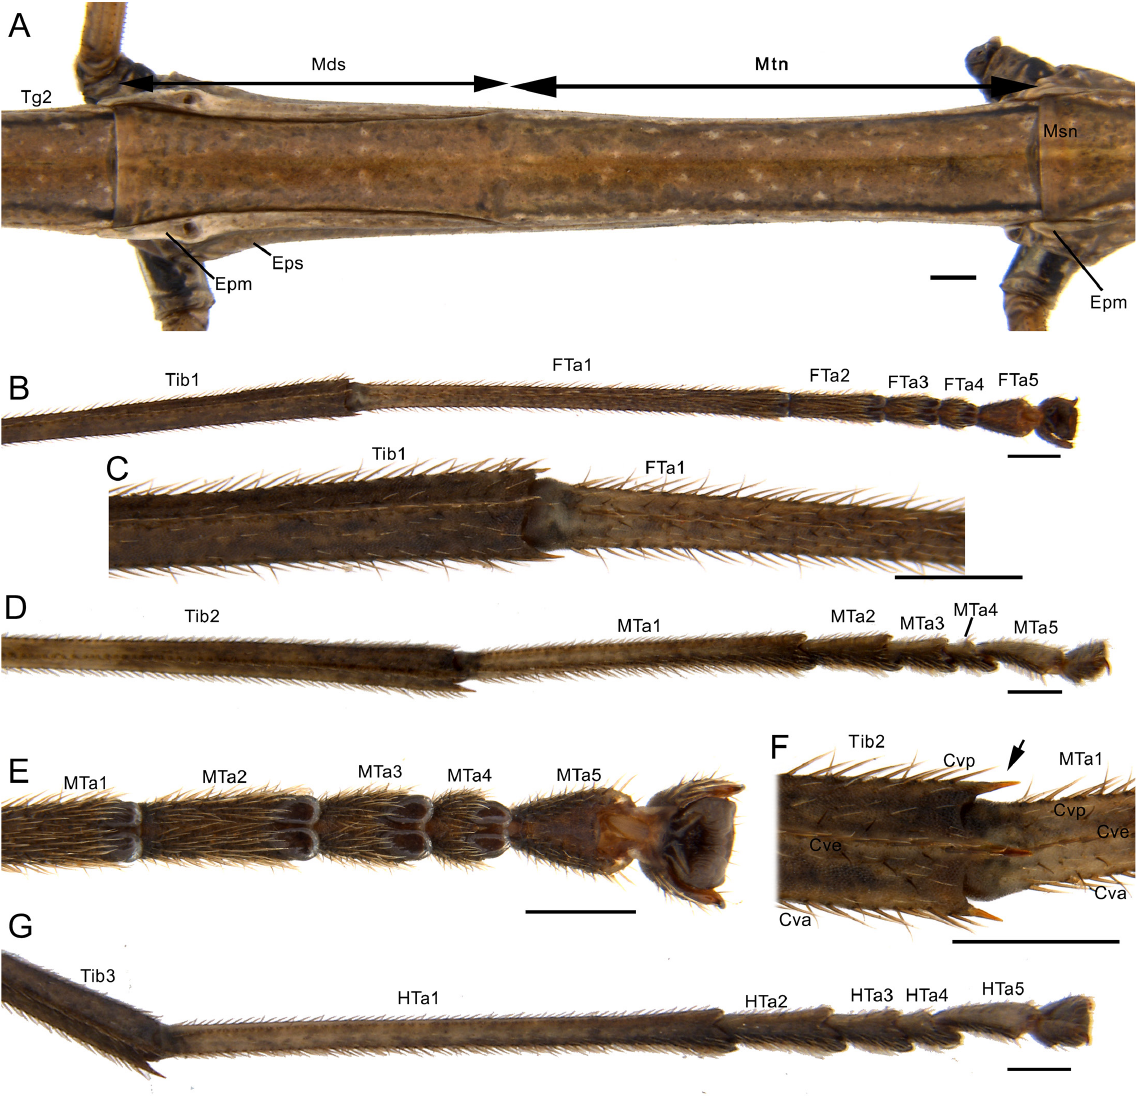
Fig. 39. Arumatia motenata Ghirotto gen. et sp. nov., paratype, ♂ (MZUSP V0602), thorax and leg morphology. A . Metathorax and median segment in dorsal view, arrows indicate the length of each segment. B . Left fore tarsus, ventral view. C . Detail of left fore tibia and tarsus. D . Right mid tarsus, retrolateral view. E . Detail of right mid tarsus, ventral view. F . Detail of right mid tibia and tarsus, ventral view, arrow showing apical sessile spine. G . Right hind tarsus, retrolateral view. Abbreviations: Cva = ventral anterior carina; Cve = ventral carina; Cvp; ventral posterior carina; Epm = epimeron; Eps = episternum; FTa = fore tarsomere; HTa = hind tarsomere; Mds = median segment; Msn = mesonotum; MTa = mid tarsomere; Mtn = metanotum; Tg = tergum; Tib = tibia. Scale bars: 0.5